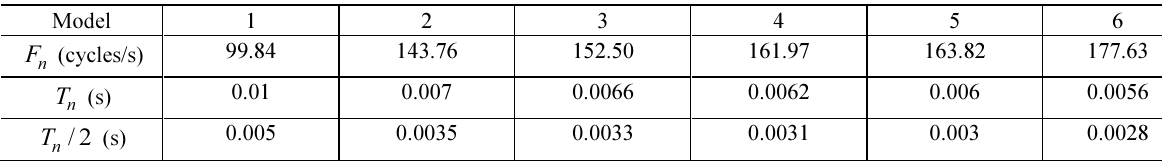
Table 1. Fundamental frequencies and periods